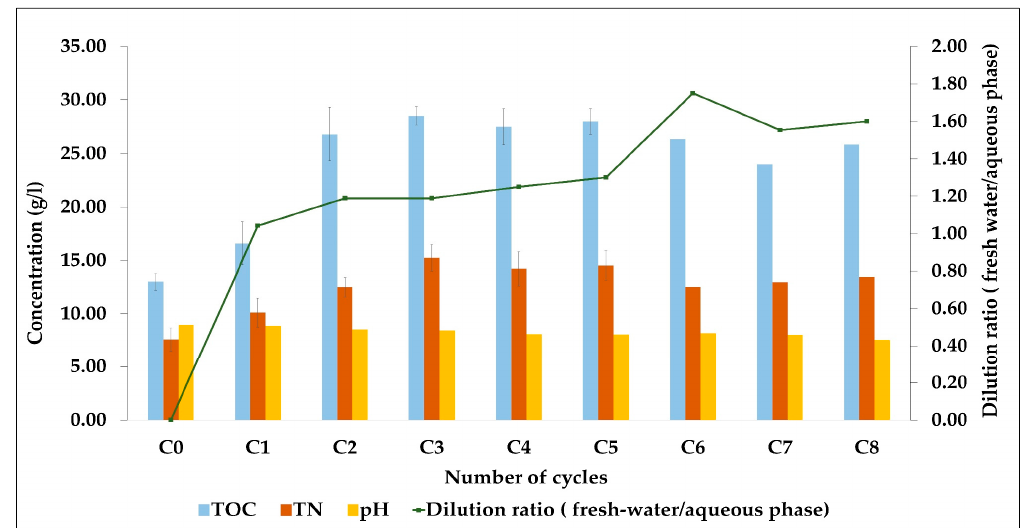
Figure 10. TOC, TN, and pH of aqueous phase.